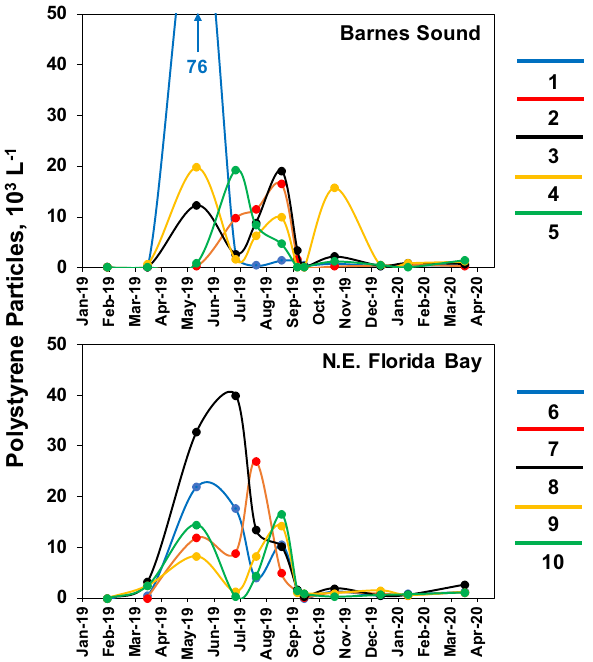
Figure 5. Concentrations of polystyrene microplastic particles at five sampling sites in Barnes Sound (1–5) and five sites in northeast Florida Bay (6–10) from January 2019 to March 2020.